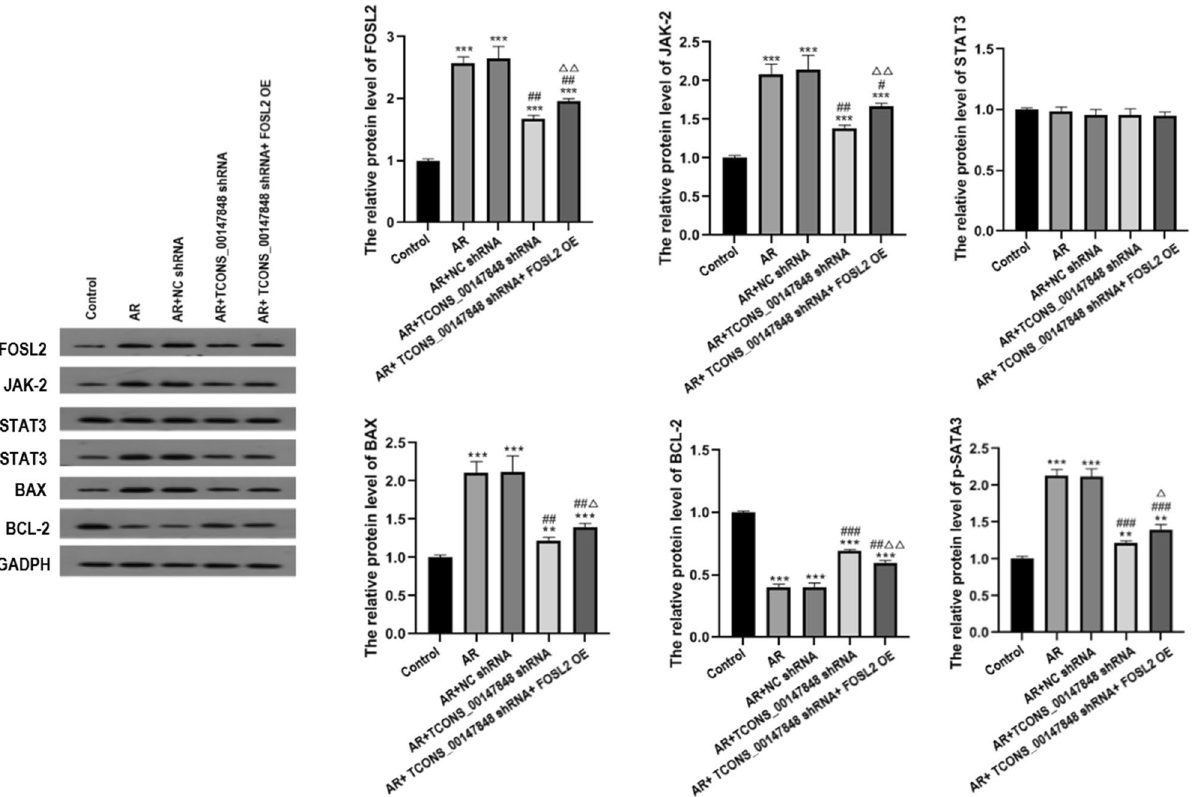
Figure 4. TCONS_00147848 and FOSL2 regulated expressions of FOSL2, JNK-2, STAT3, P-STAT3, BAX, and BCL-2 in mice detected by Western blot. ** P < 0.01 vs. Control group, # P < 0.05 vs. AR group, ## P < 0.01 vs. AR group, ### P < 0.001 vs. AR group, △ P < 0.05 vs. AR + TCONS_00147848 shRNA group, △△ P < 0.01 vs.